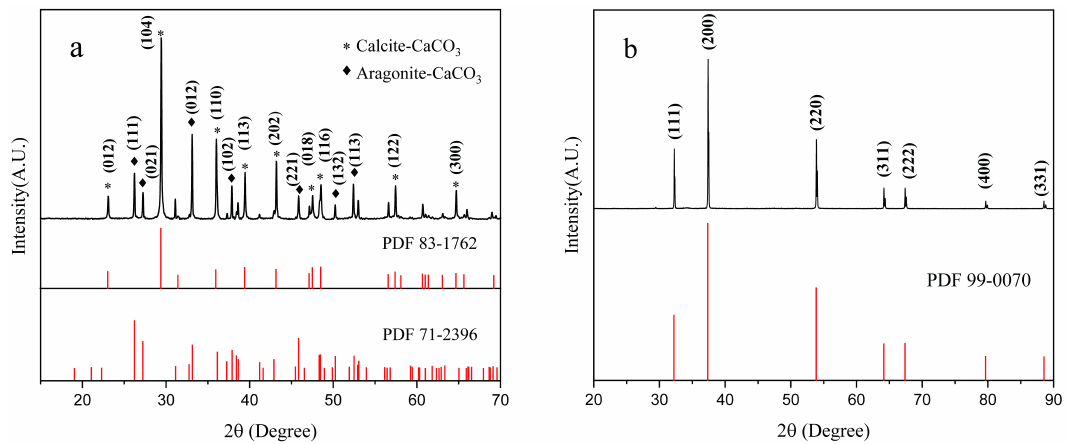
Figure 3. XRD of ( a ) USP and ( b )